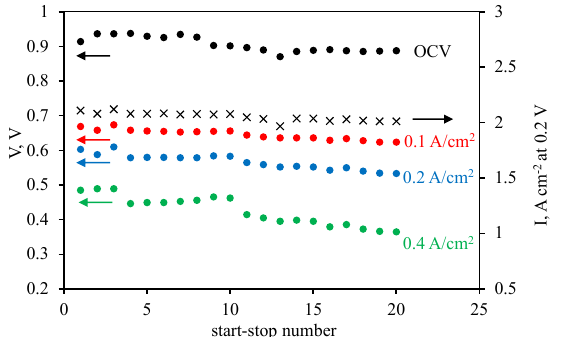
Figure 3. Variation of the open cell voltage and cell voltages measured at 0.1, 0.2, and 0.4 A cm − 2 variation with start–stop cycle number. The MEA was assembled with the reinforced membrane, Celtec®P1000 anode, and Celtec®P1000 cathode. The second Y-axis shows the current density measured at 0.2 V in this series of experiments.